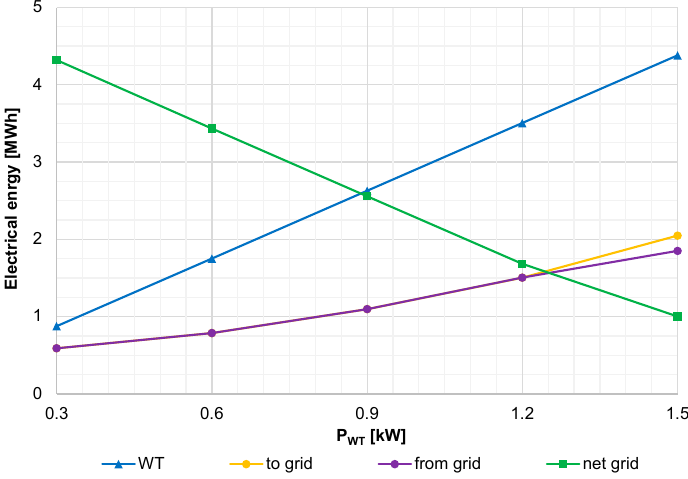
Figure 14. Main electrical energies of the system vs. variation of the WT power, parametric analysis.